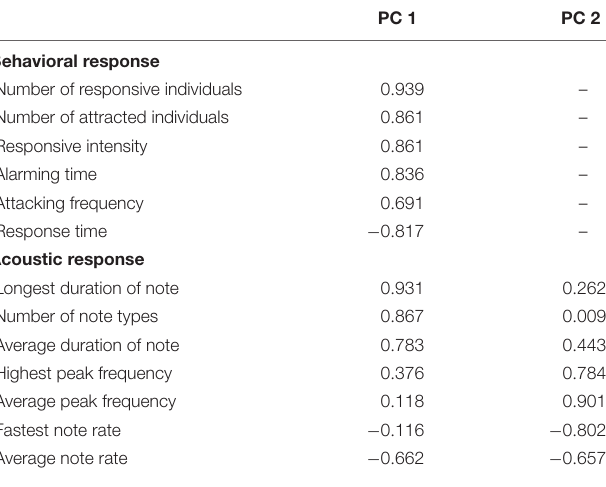
TABLE 2 | Components, extracted by principal component analysis, for behavioral and acoustic responses in A. orientalis